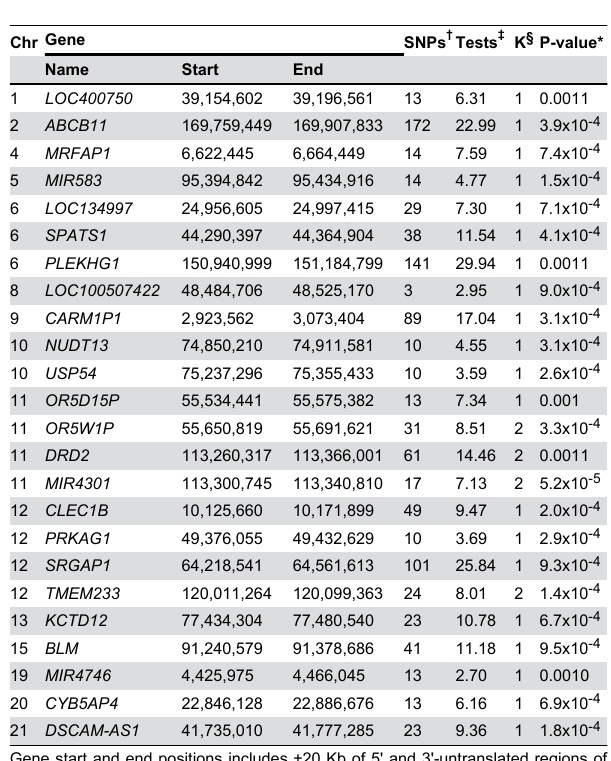
Table 3. Gene-based association analysis of systolic blood pressure.